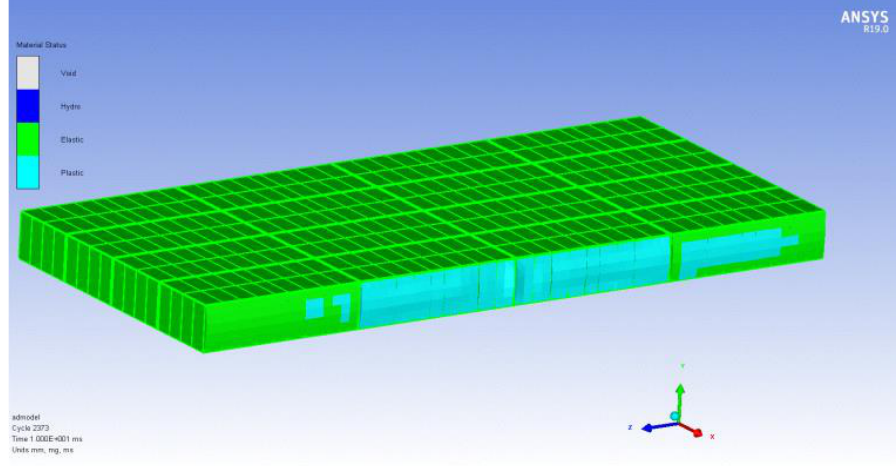
Figure 19. Deformations on the mitigation panels.